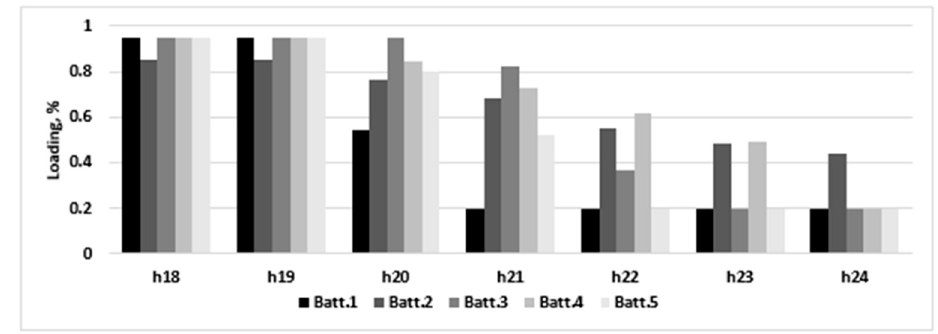
Figure 12. The discharge pattern for the batteries, Scenario 3.